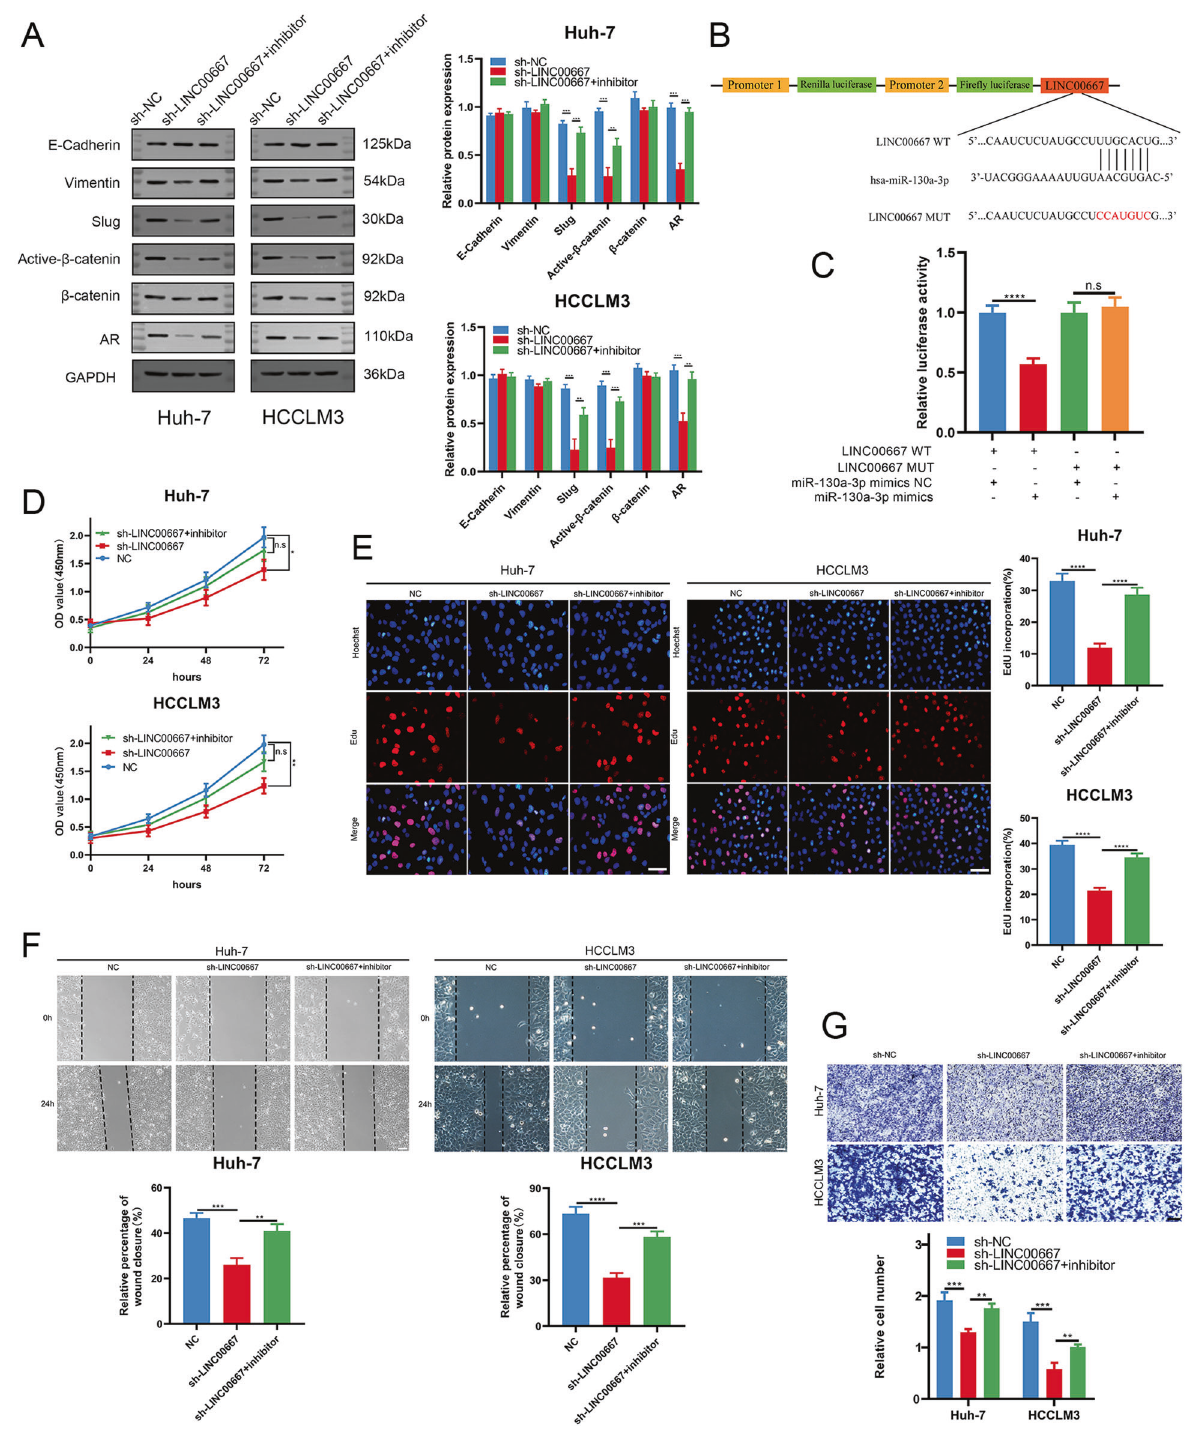
Fig. 5 LINC00667 aggravates CP, CM and CI in HCC cells via LINC00667/miRNA-130a-3p/AR axis. A Relative protein levels of AR, Slug and active- β -catenin in HCCLM3/Huh-7 cells transfected with sh-LINC00667, sh-NC or sh-LINC00667 + miRNA-130a-3p inhibitor were evaluated by immunoblotting. B and C Complementary sequences of miRNA-130a-3p and LINC00667-WT. The putative binding sites of miRNA-130a-3p was mutated in LINC00667-MUT. 293 T cells co-transfected with miRNA-130a-3p mimic and LINC00667-WT or LINC00667-MUT vector were respectively detected for luciferase activity. Data ( n = 3) were analyzed by student ’ s t test. D and E Proliferative abilities of HCCLM3/Huh-7 cells transfected with sh-LINC00667, NC or sh-LINC00667 + miRNA-130a-3p inhibitor were determined by CCK-8 and EdU assays, respectively. Scale bar, 100 μ m. Data were analyzed by one-way ANOVA. F Migratory capabilities of HCCLM3/Huh-7 cells transfected with sh-LINC00667, NC or sh- LINC00667 + miRNA-130a-3p inhibitor were determined by wound healing assays. Scale bar, 100 μ m. Data were analyzed by one-way ANOVA. G Invasive capabilities of HCCLM3/Huh-7 cells transfected with sh-LINC00667, NC or sh-LINC00667 + miRNA-130a-3p inhibitor were determined by transwell assays. Scale bar, 150 μ m. Data were analyzed by one-way ANOVA. Data, mean ± S.D.; ns, no signi fi cance. *, **, *** and **** = P < 0.05, < 0.01, < 0.001 and < 0.0001,